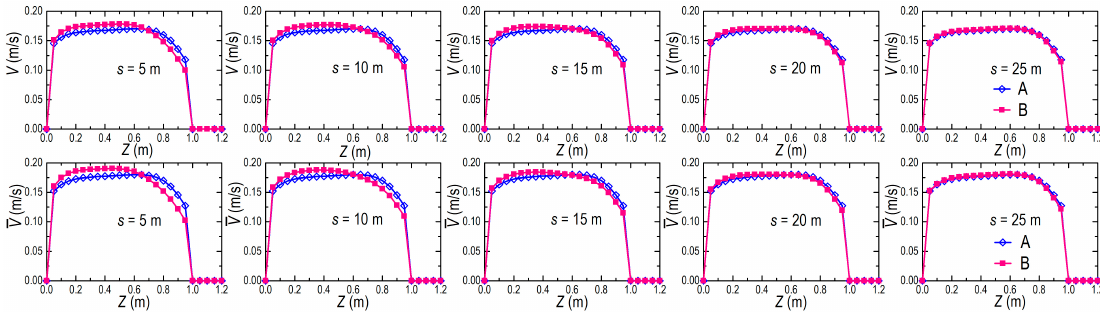
Figure 7. Comparison of lateral distributions V ( Y = 0.05 m) and V at A and B with di ff erent spacing levels.